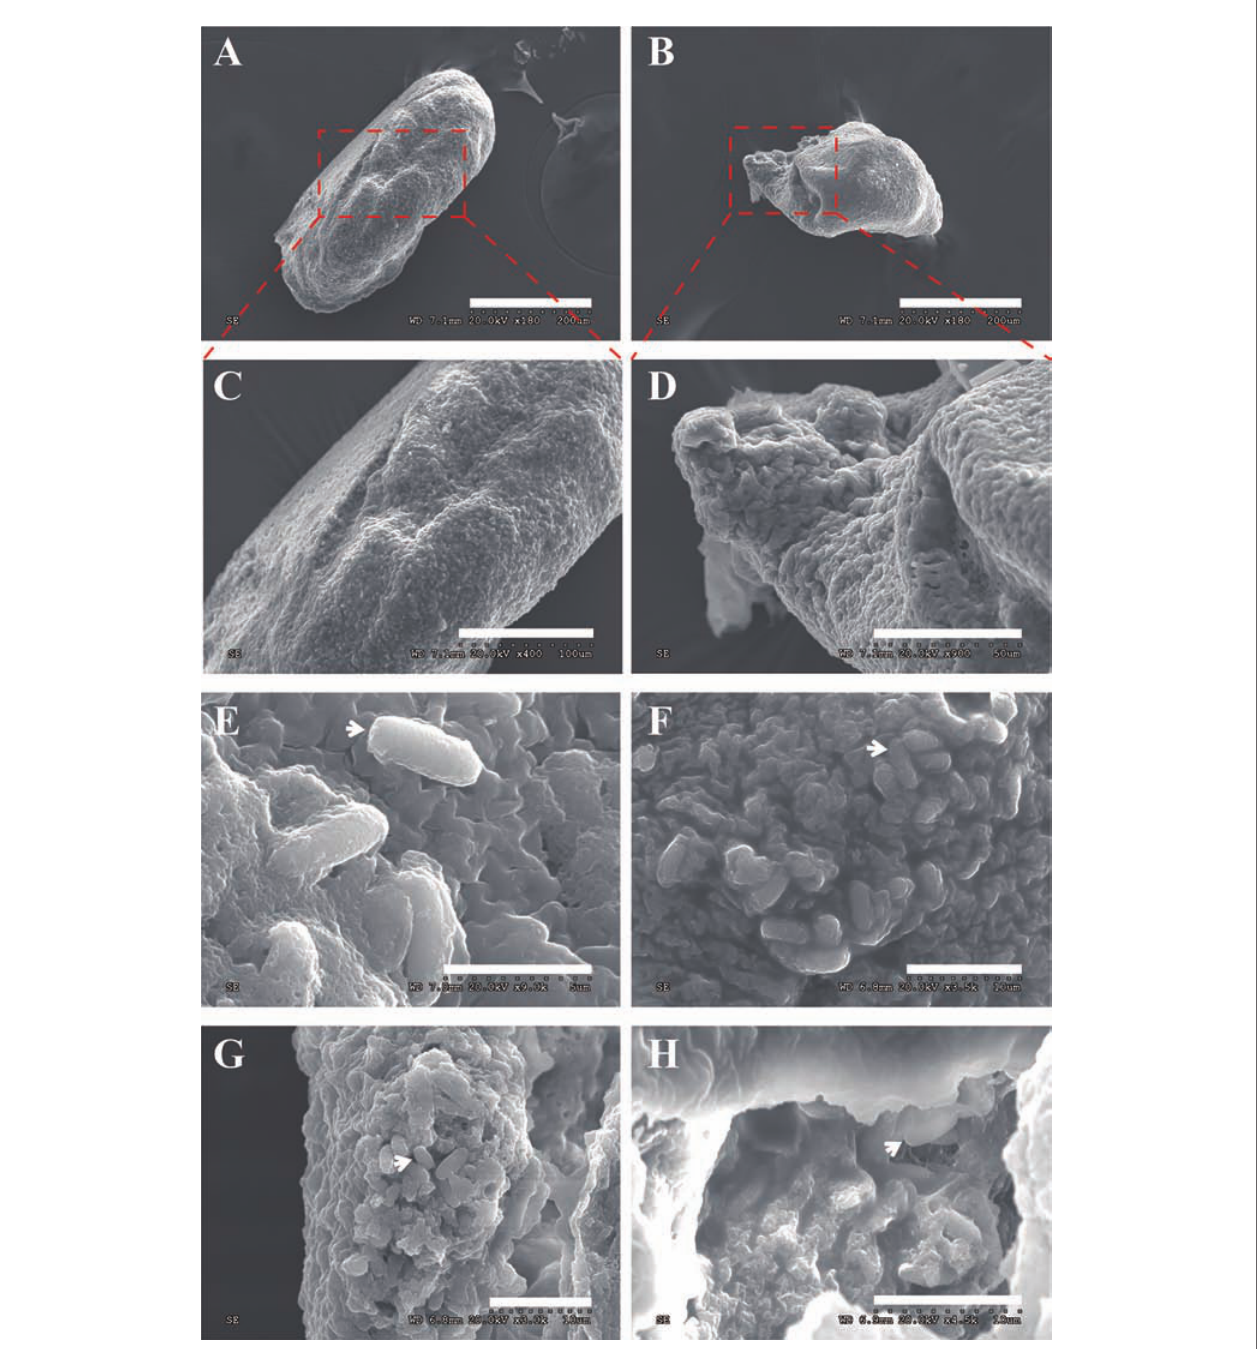
FIGURE 3 | The xenoma observed by SEM. (A, B) The elliptical and spindle intact xenoma. (C, D) The enlarged graph of the dotted box in panels (A, B, E) The mature spores (arrowhead) adhering to the surface of the xenoma, the bar is 50 µm. (F) The mature spores inlaid on the surface of the xenoma, the bar is 10 µm. (G, H) The mature spores embedded in a transverse xenoma. Bar, 10